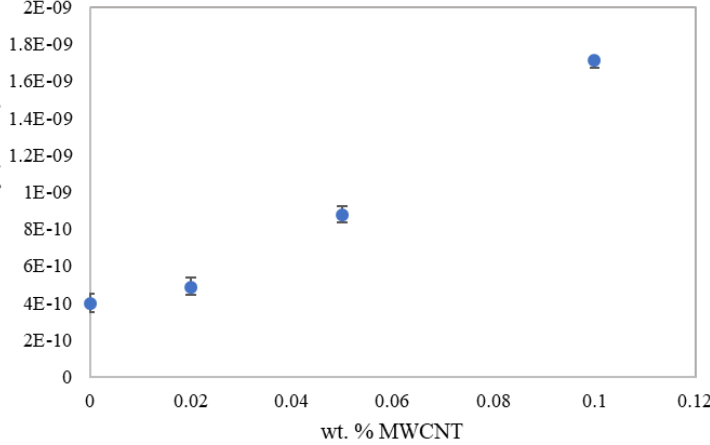
Figure 7. Electrical conductivity of the control sample and cementitious samples reinforced with different amounts of